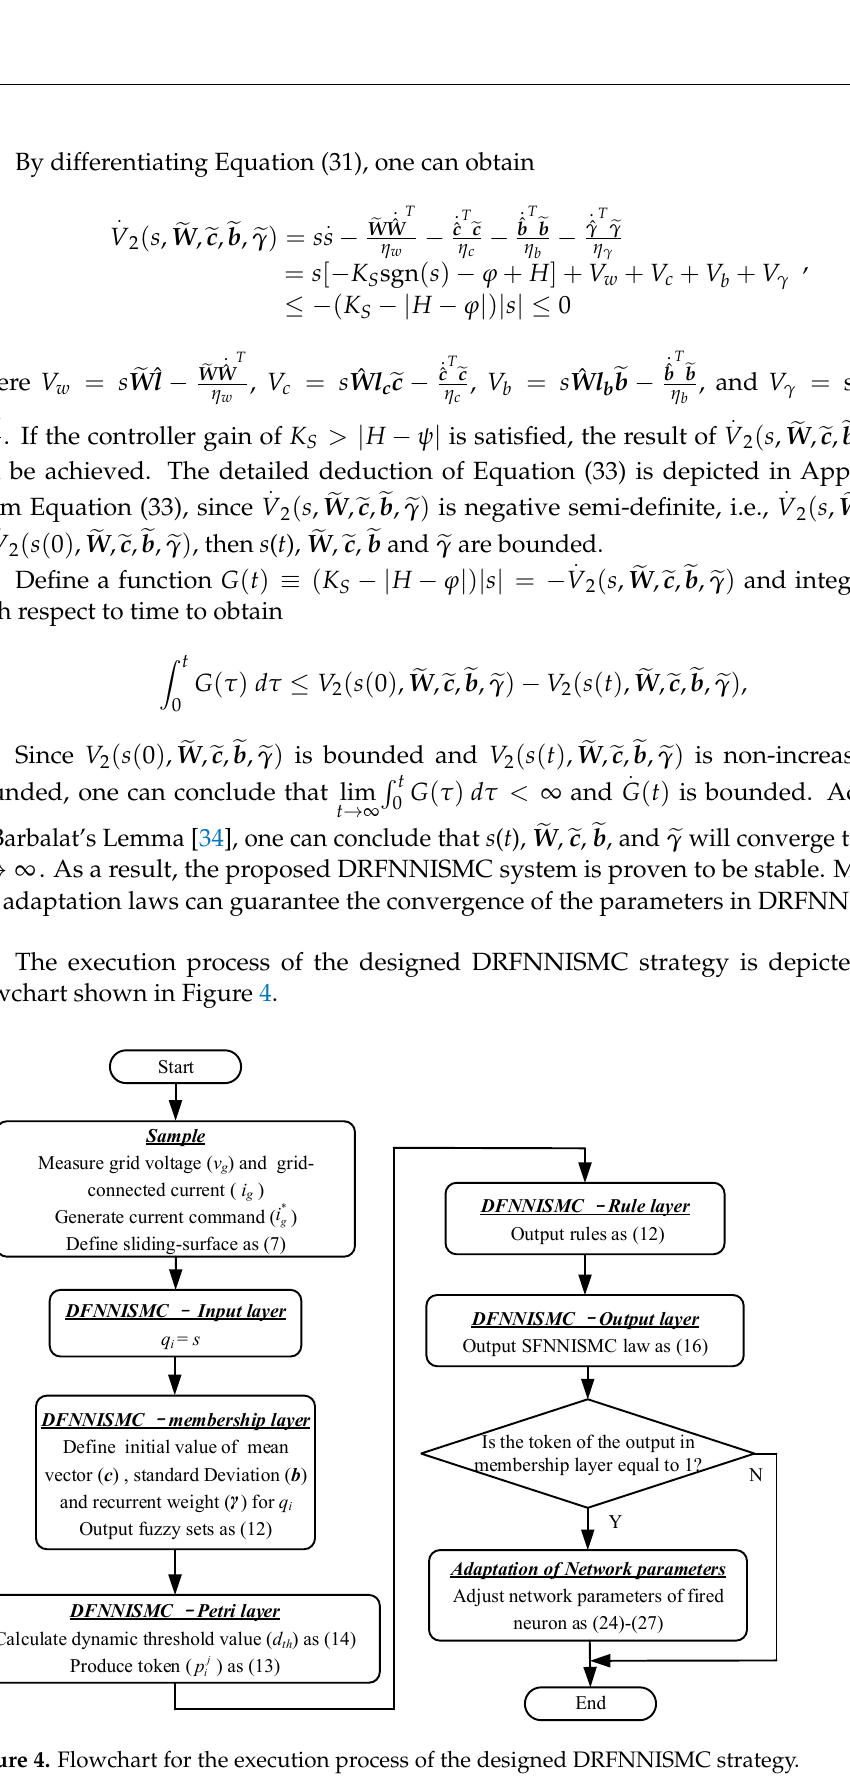
Figure 4. Flowchart for the execution process of the designed DRFNNISMC strategy.